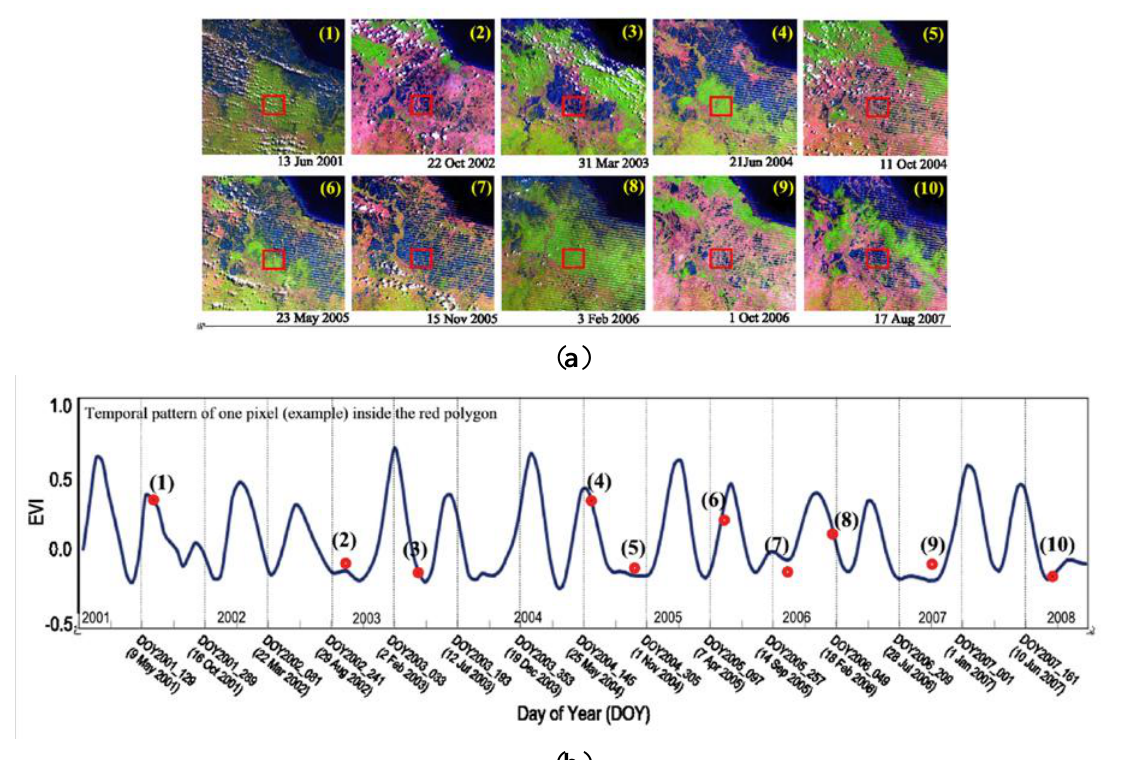
Figure 4. ( a ) Landsat ETM+ dates in conjunction with the seven-year datasets; ( b ) temporal pattern of MODIS EVI profile. The profile below was assigned to double cropping paddy field in Java Island. The EVI value of the red rectangle of each image in Figure 4a is located by the red point in Figure 4b.